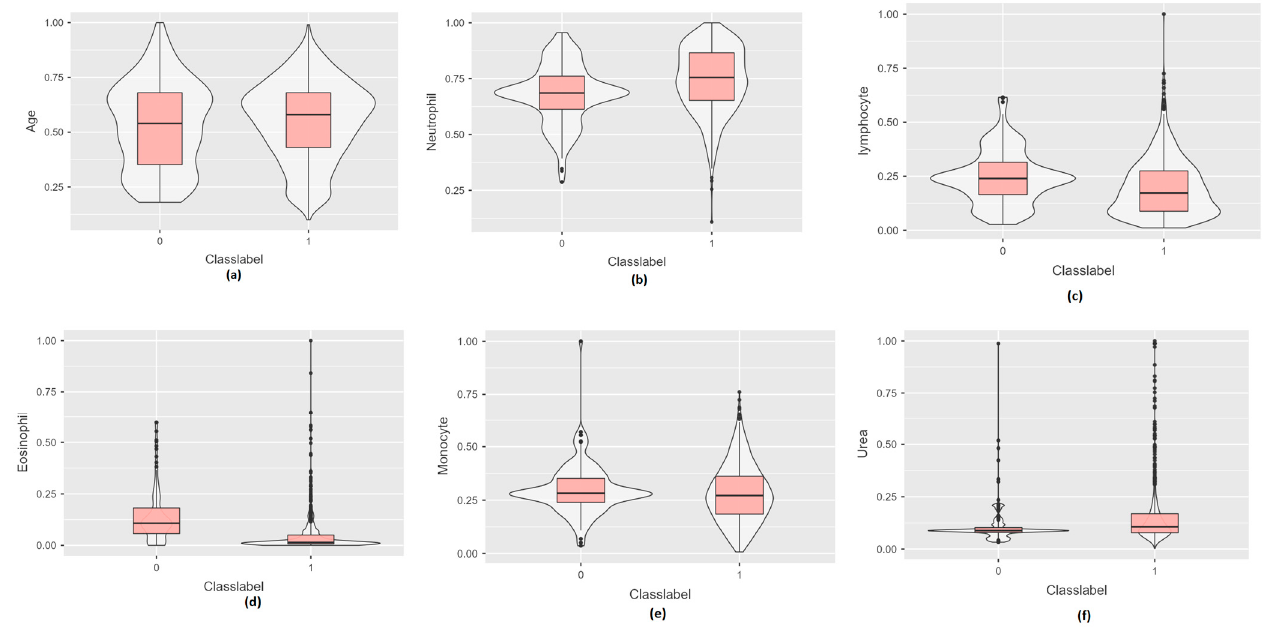
Figure 1. Violin plots used to represent COVID-19 and non-COVID-19 patients. (0—non COVID-19 ILI patients, 1—COVID-19 patients). ( a ) Age ( b ) Neutrophil ( c ) Lymphocyte ( d ) Eosinophil ( e ) Monocyte ( f ) Urea.